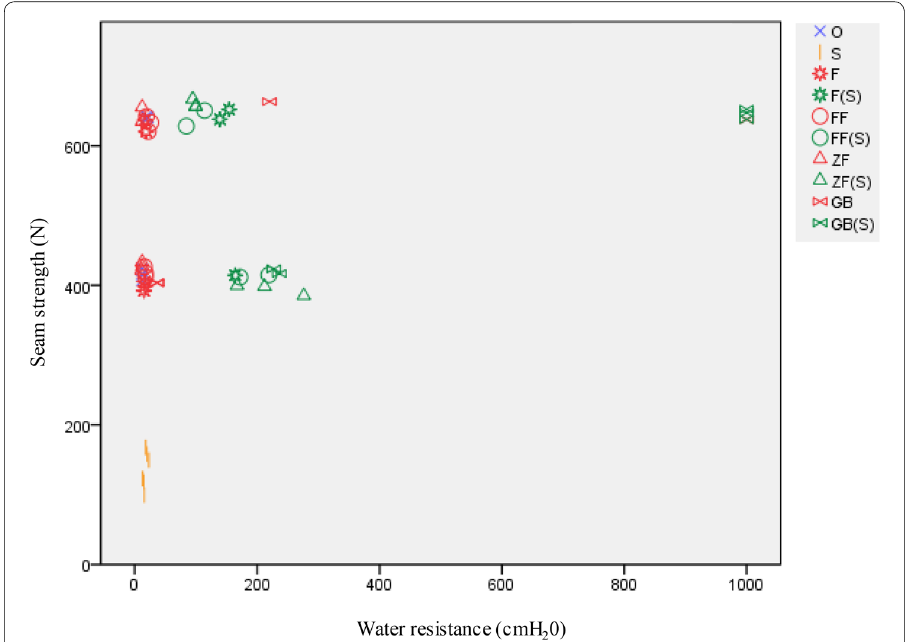
Fig. 6 Graph of seam strength and water resistance measurement by sewing